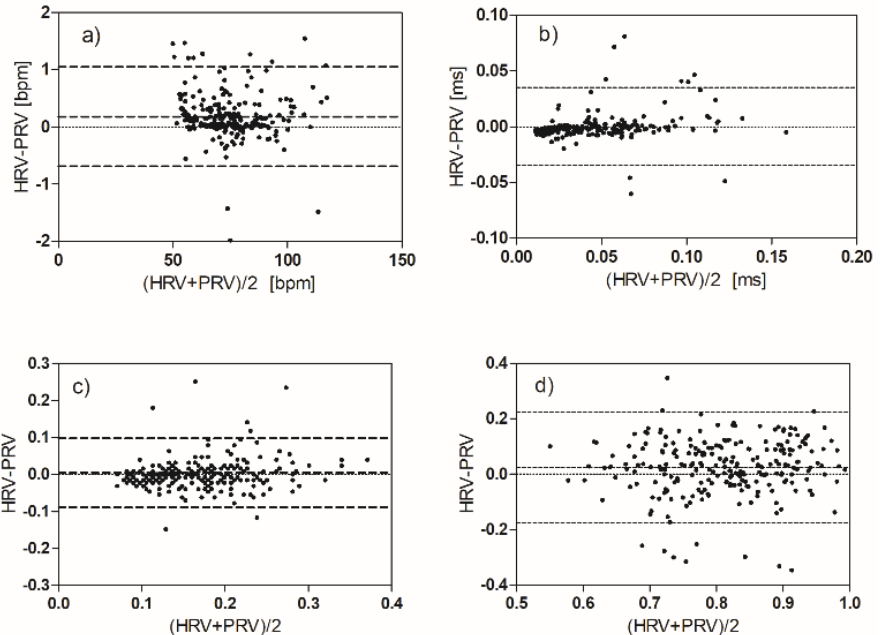
Figure 8. Bland − Altman plots comparing HRV and PRV measurements: ( a ) HR, ( b ) RMSSD, ( c ) TINN, ( d ) ApEn.